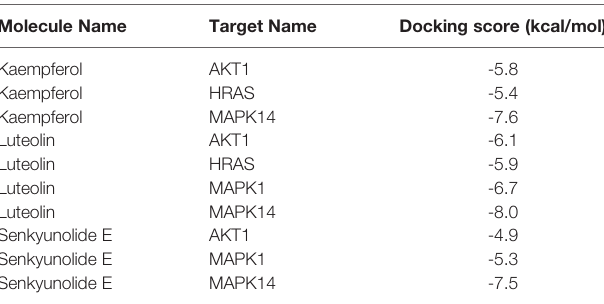
TABLE 4 | Molecular docking